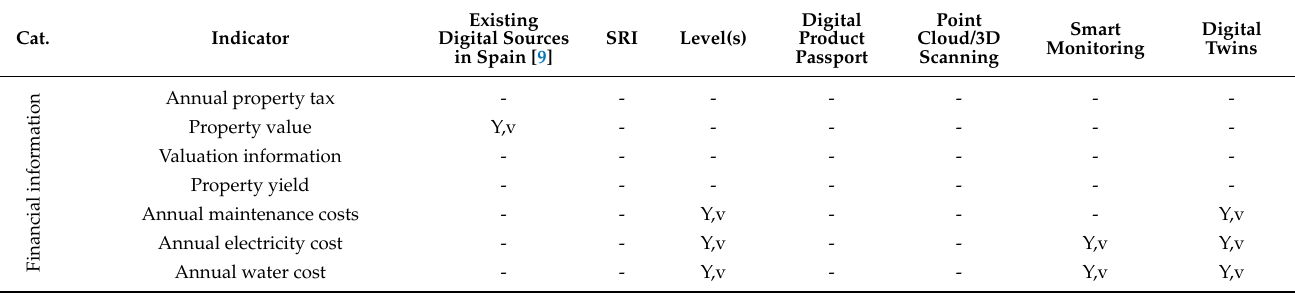
Table A5. Category 5: Financial